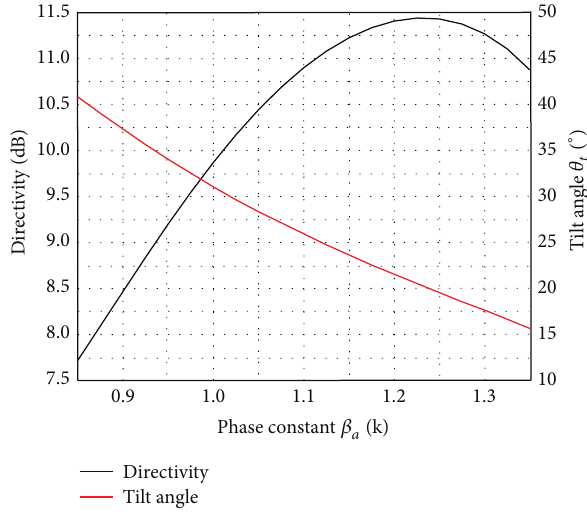
Figure 5: The relationships between 𝛽 𝑎 and directivity, 𝛽 𝑎 and tilt angle for 10-element monopole end-fire array with a finite ground = 200 mm, 𝐿 = 30 mm, and 𝑊 = 60 mm at 𝑓 = 3 GHz. 𝐿 𝑎 𝑔